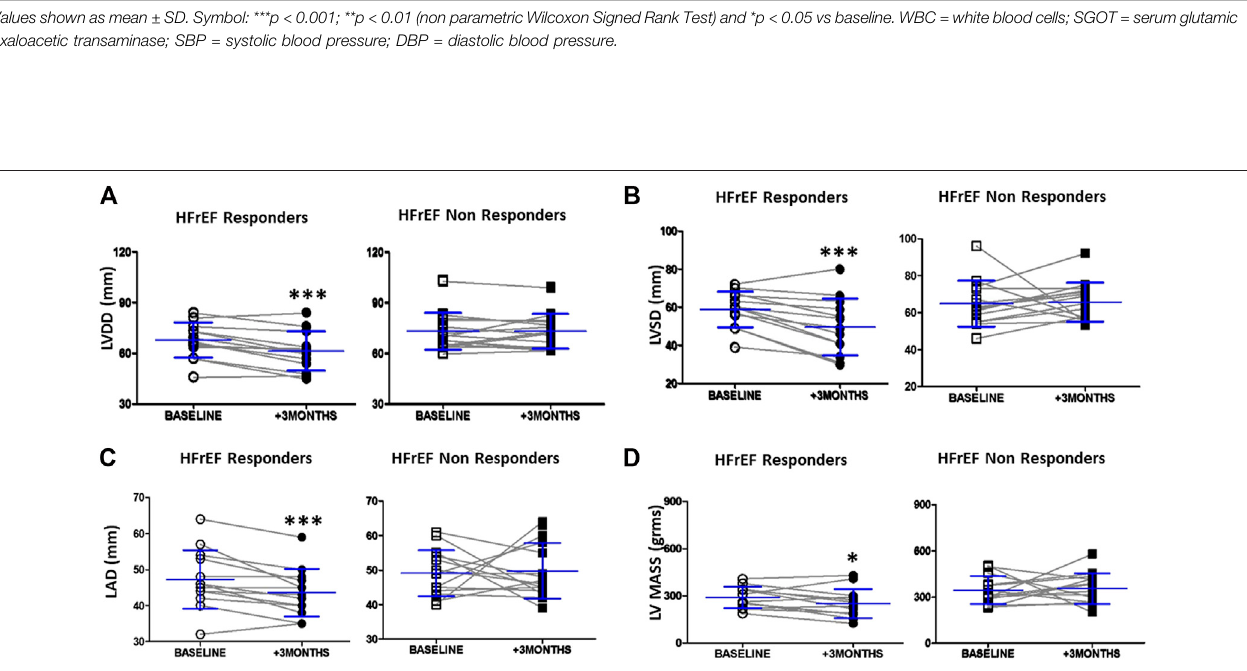
FIGURE1| LVandleftatrialdimensionsbeforeandafter 3 months ofcardiac resynchronizationtherapyinresponders andnonrespondersHFrEF patients (A) Dot graph of left ventricle diastolic diameter in responders patients ( n (cid:1) 13, white circles (cid:1) baselines and black circles (cid:1) + 3 months) and non responders patients ( n (cid:1) 15, white squares (cid:1) baselines and black squares (cid:1) + 3 months) (B) Dot graph of left ventricle systolic diameter in responders patients ( n (cid:1) 13, white circles (cid:1) baselines and blackcircles (cid:1) + 3 months) and nonresponders patients( n (cid:1) 15, whitesquares (cid:1) baselines and black squares (cid:1) +3 months) (C) Dot graphofleft atrial diameter in responderspatients( n (cid:1) 13,whitecircles (cid:1) baselinesandblackcircles (cid:1) +3 months)andnonresponderspatients( n (cid:1) 15,whitesquares (cid:1) baselinesandblacksquares (cid:1) + 3 months) (D) Dot graph of left ventricle mass in responders patients ( n (cid:1) 13, white circles (cid:1) baselines and black circles (cid:1) + 3 months) and non responders patients ( n (cid:1) 15, white squares (cid:1) baselines and black squares (cid:1) + 3 months). Data are shown as mean ± SD. Symbols: *** p (cid:1) < 0.001; ** (cid:1) p < 0.01 (non parametric Wilcoxon Signed Rank Test); * (cid:1) p < 0.05 vs. baseline, respectively. Abbreviations: DD (cid:1) end diastolic diameter, SD (cid:1) end systolic diameter, LAD (cid:1) left atrial diameter, LV (cid:1) left